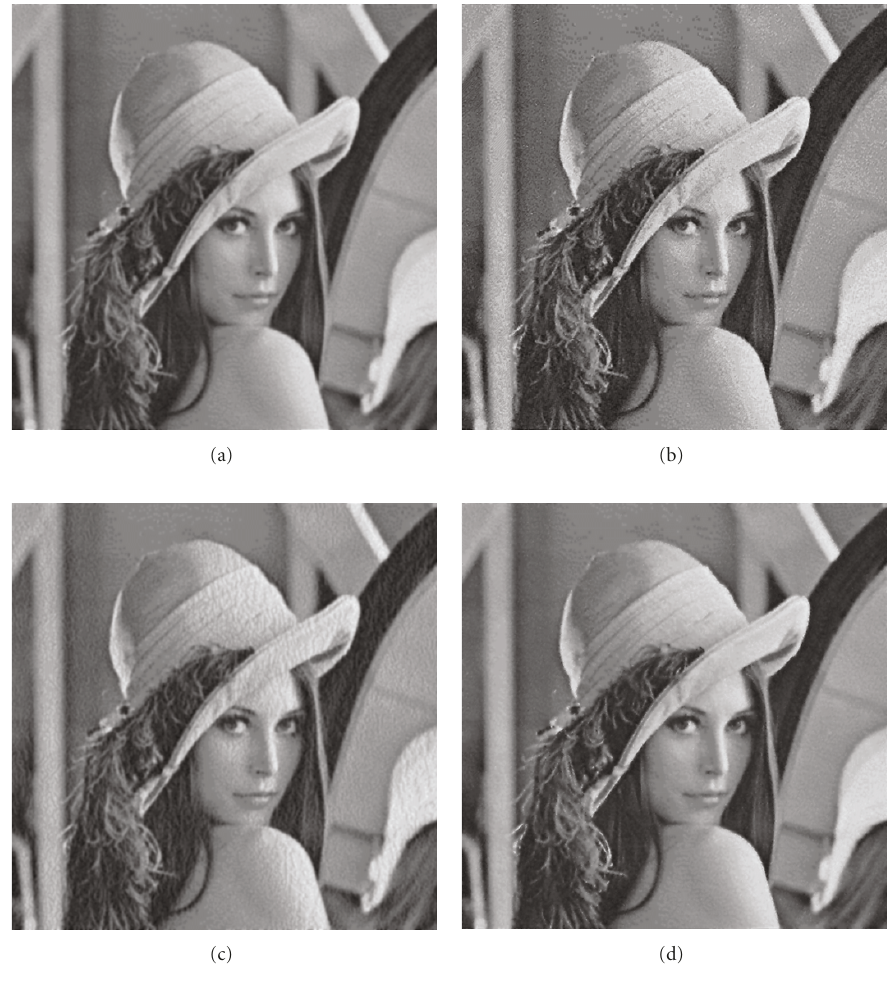
Figure 17: The inverse halftoning results using di ff erent methods: (a) the reconstructed image using Gaussian filtering; (b) the reconstructed image using LUT method; (c) the reconstructed image using ELUT method; (d) the reconstructed image using the proposed